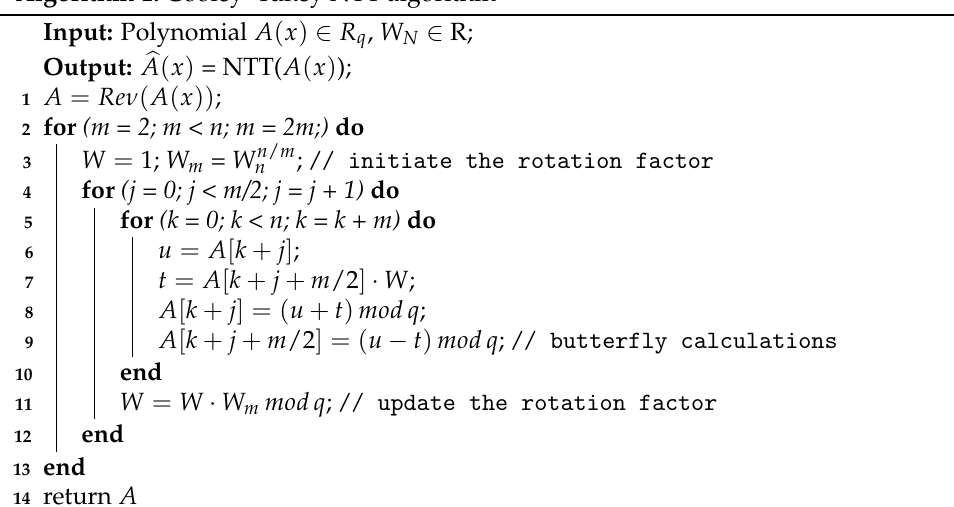
Algorithm 1: Cooley–Tukey NTT